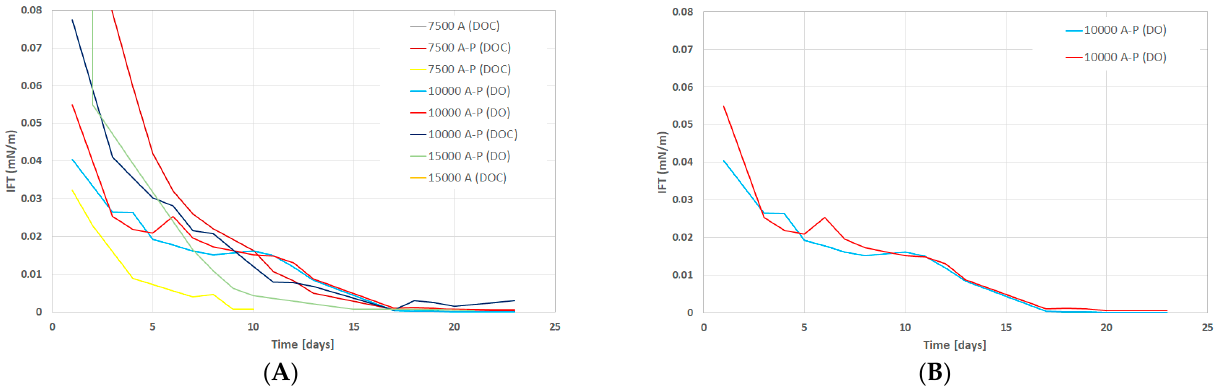
Figure 7. IFT variation over time (days) for the tested formulations in the phase behavior tests. ( A ) IFT versus time for various concentrations and ( B ) IFT versus time for 10,000 AP to show the data reproducibility. A refers to alkali concentration in ppm, P stands for polymer concentration of 1850 ppm, (DOC) represents dead oil with cyclohexane, and (DO) represents dead oil. Table 7. Summary of volume relation from phase behavior and IFT for 7500 ppm A and AP deter- mined using the Chun Huh equation (Liu et al. 2008) for alkali and alkali–polymer in 10 mL oil sample. IFT = Ratio Vphase/Vphase * c, c = 0.3 nM/m (Liu et al. 2008)—correction factor. Lower phase = water, middle phase = emulsion, upper phase =